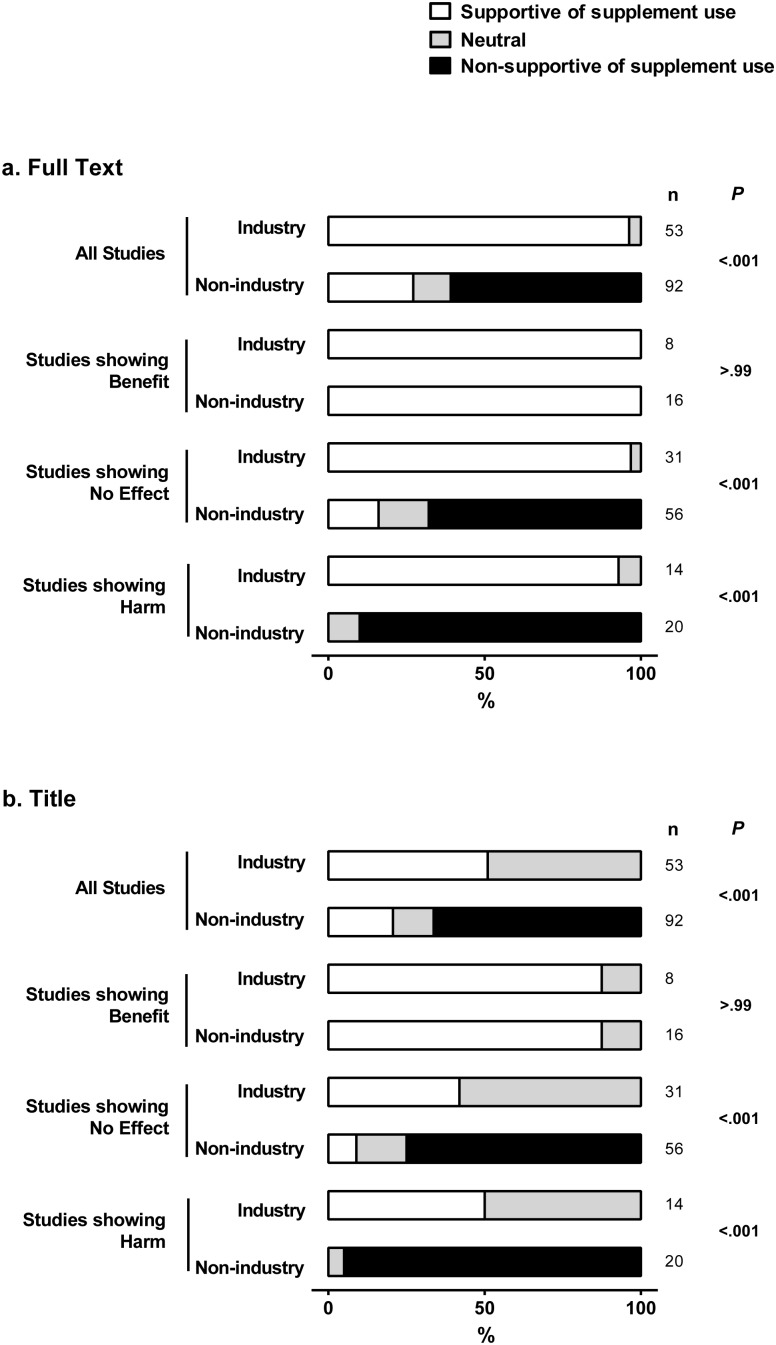
Disposition of industry and non-industry media responses towards use of supplements, according to outcome of source publications.Data on the bars are the percentage of full text (a) and titles (b) of media responses that are supportive, non-supportive or neutral towards supplement use.